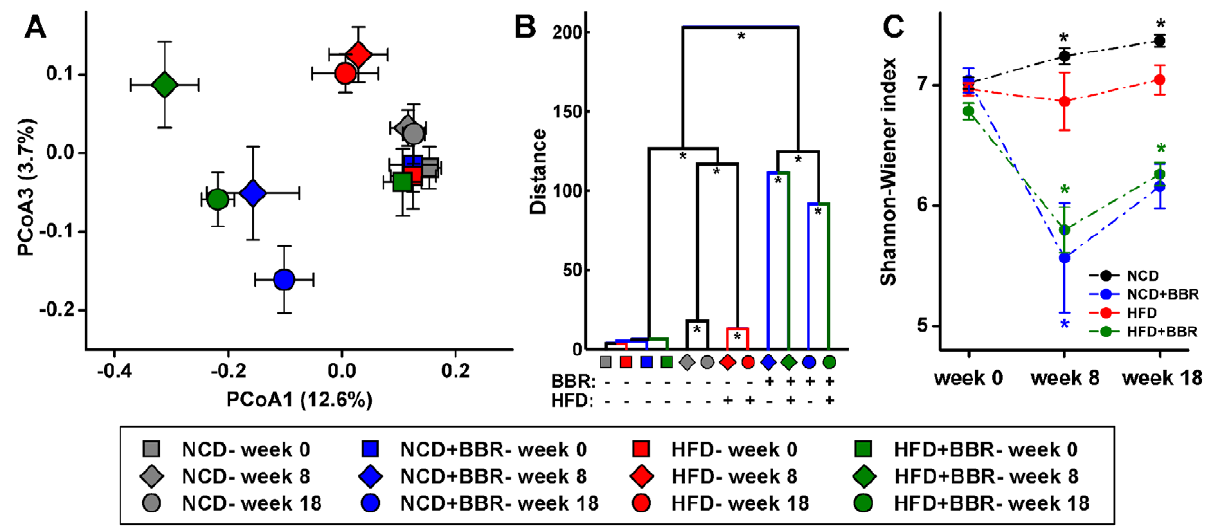
Figure 4. Overall structural changes of gut microbiota. (A) PCoA score plot based on unweighted UniFrac metrics. Each point represents the mean principal component scores of all rats in a group at one time point, and the error bar represents the standard deviation. (B) Clustering of gut microbiota based on mahalanobis distances calculated using MANOVA, * P , 0.05. (C) Shannon-Wiener index, calculated after rarefying to an equal number of sequence reads for all samples. Values are expressed as means 6 standard error. * P , 0.05, significant difference when compared with the